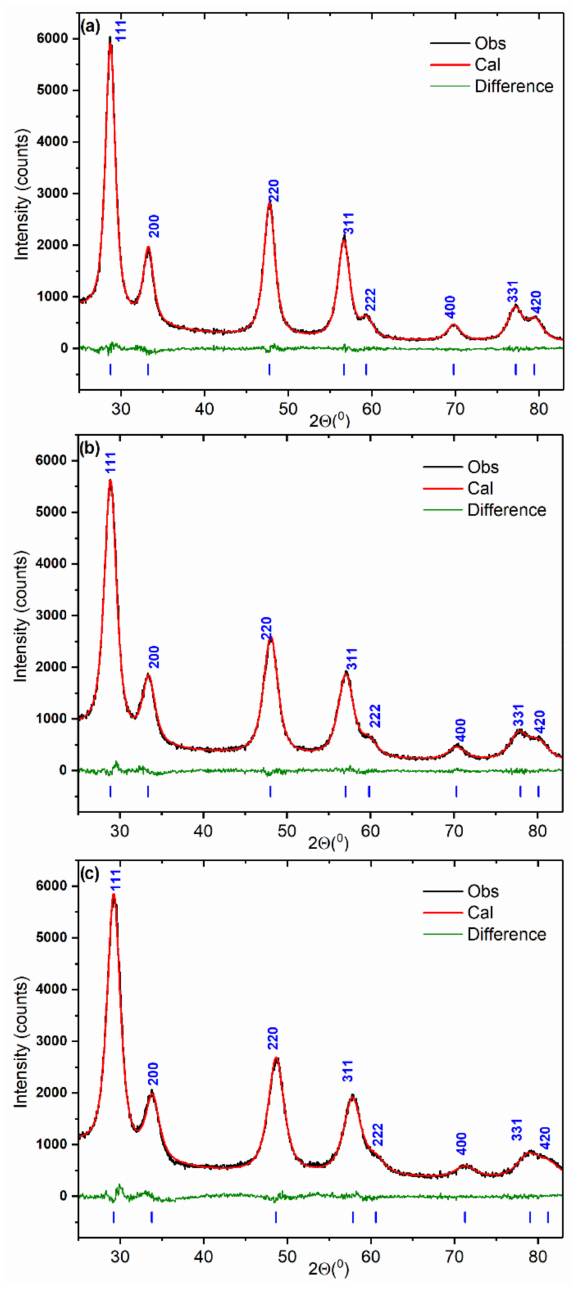
Figure 1. XRD patterns fitted using the Rietveld refinement method for Ce 0.9 Zr 0.1 O 2 ( a ), Ce 0.75 Zr 0.25 O 2 ( b ), and Ce 0.5 Zr 0.5 O 2 ( c ) mixed oxides. Table 2. Structural parameters of Ce 1 − x Zr x O 2 oxides determined from XRD